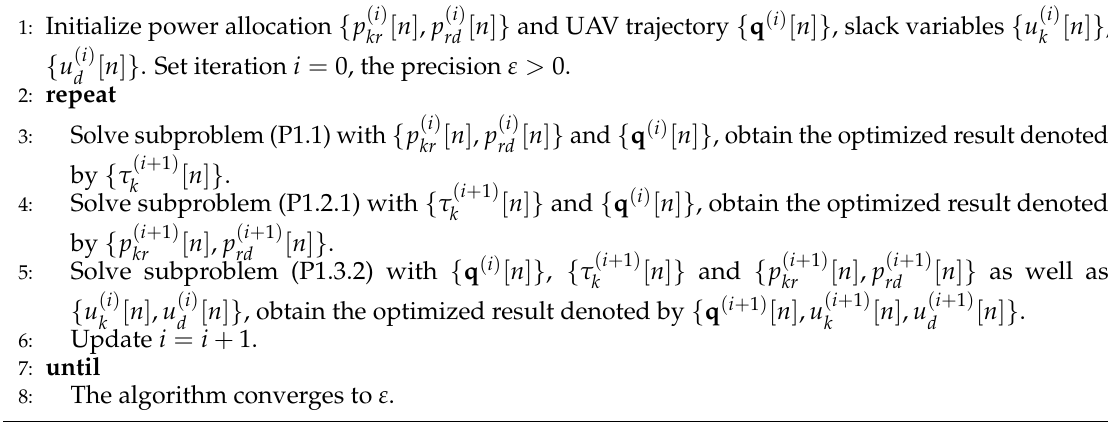
Algorithm 1 An iterative algorithm for solving Problems (P1) and